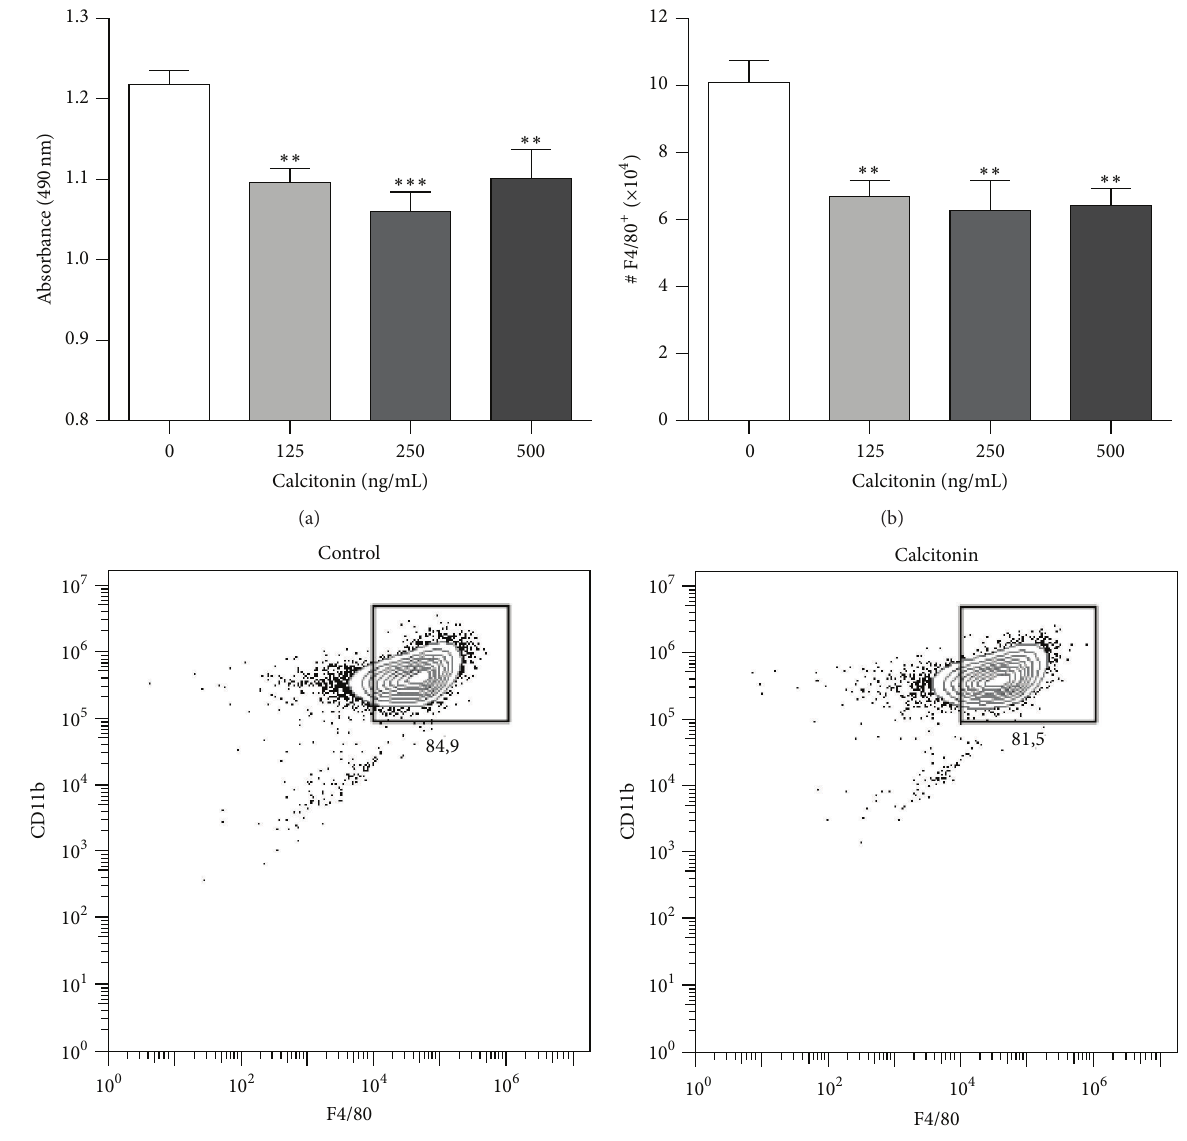
Figure 6: Impact of calcitonin on macrophage differentiation in vitro . Nonadherent cells of bone marrow at 10 6 cells/mL were cultured during 5 days in macrophage differentiation medium with different concentrations of calcitonin ( 𝑛 = 7 –9). Cell proliferation was evaluated by MTS/PMS assay (a) and macrophage counts (F4/80 + cells) were assessed by cytometry following identification panel (c). Data are mean ± SEM and values are compared to controls using a one-way ANOVA test. ∗ 𝑃 < 0.05 ; ∗∗ 𝑃 < 0.01 ; ∗∗∗ 𝑃 < 0.001